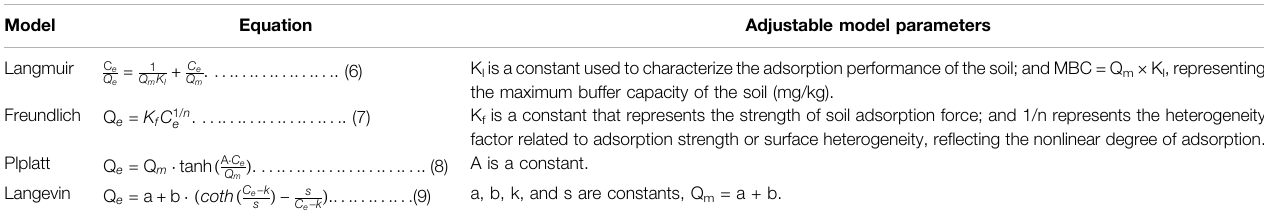
TABLE 5 | Four thermodynamic models. Model Equation Adjustable model